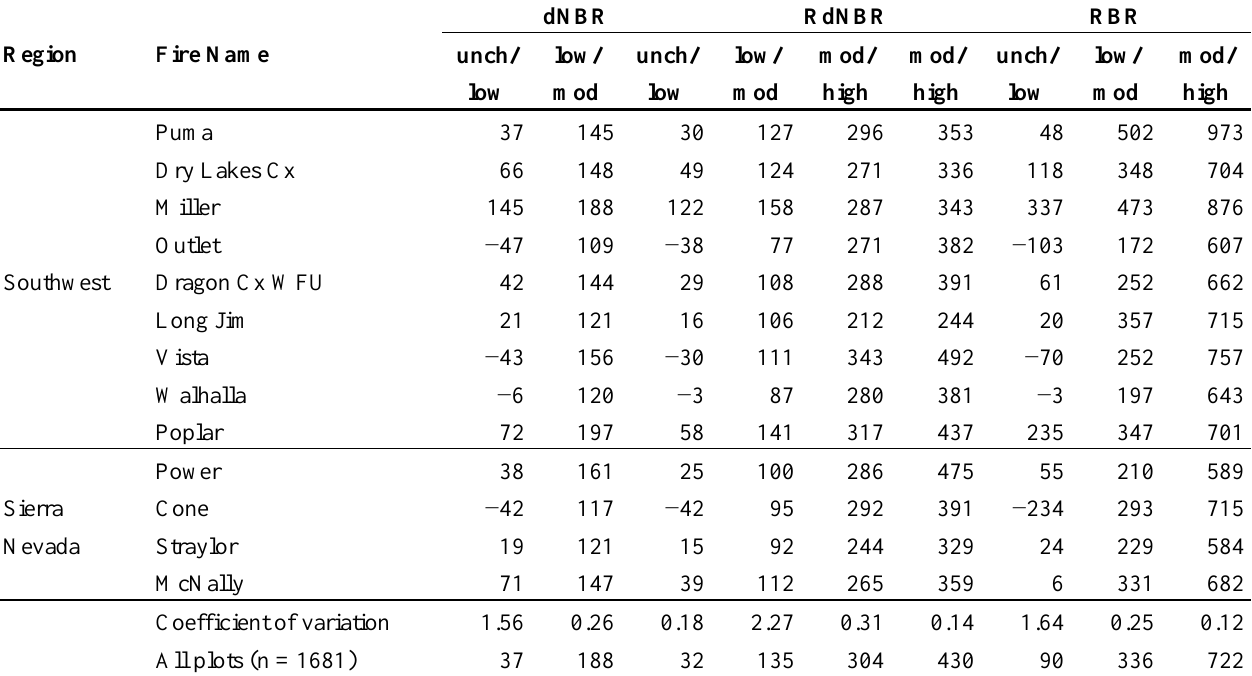
Table A3. Producer’s and user’s accuracy for all plots (n = 1681) for each severity class for the three burn severity metrics evaluated in this study. These values use the thresholds developed for all plots and evaluate the burn severity grids that include the dNBR